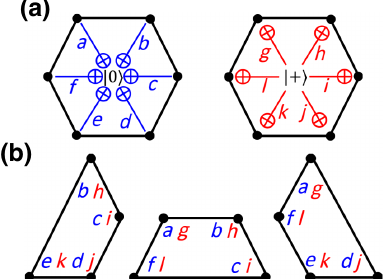
FIG. 13. (a) The CNOT schedule { a , b , c , d , e , f ; g , h , i , j , k , l } is a list specifying the time units when each CNOT gate is applied. At the end, the ancillas, which are initially prepared in | 0 (cid:2) and |+(cid:2) , are measured to extract the Z - (blue) and X - (red) stabilizer measurement outcomes, respectively. (b) The CNOT schedules for stabilizers on faces along the boundary can be viewed as restrictions of the CNOT schedule in